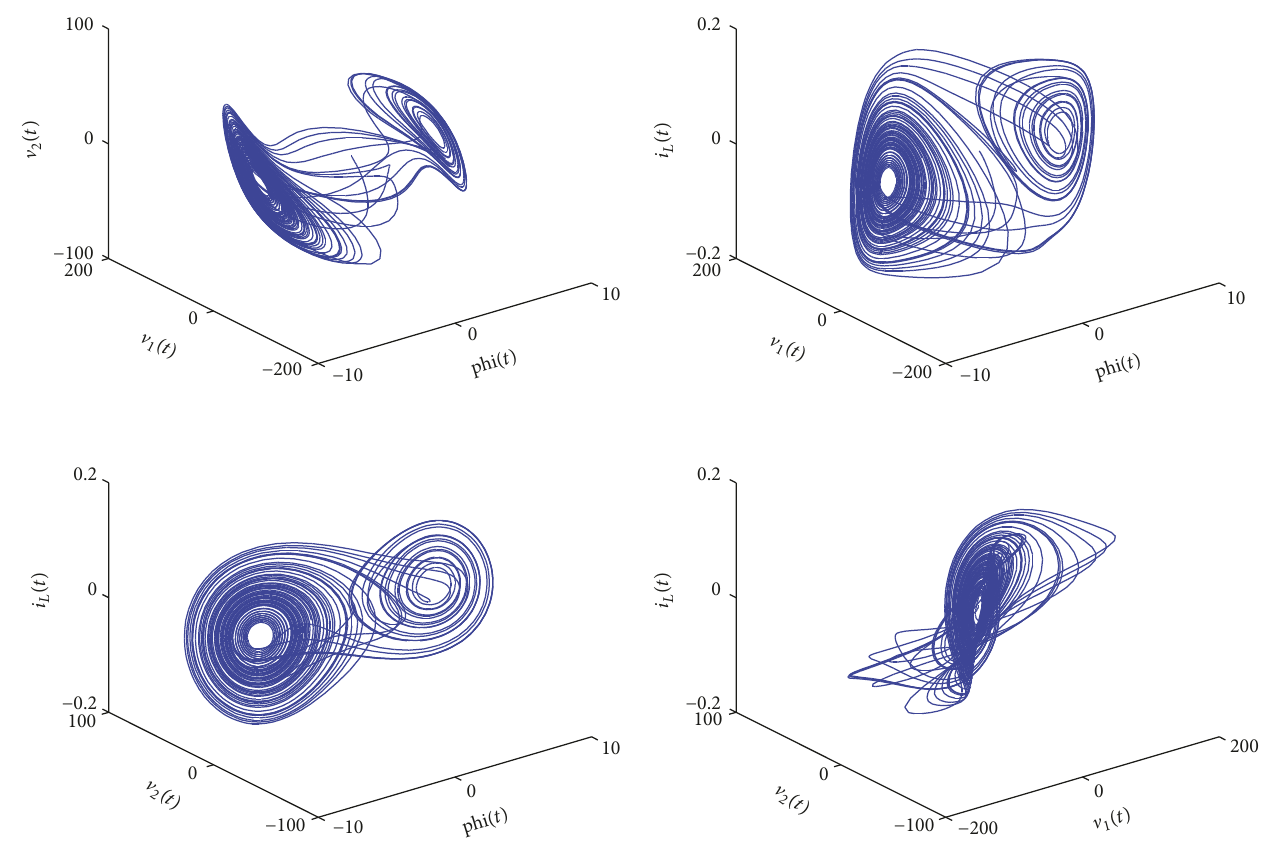
Figure 1: The state trajectory of the memristor based chaotic circuit shown in